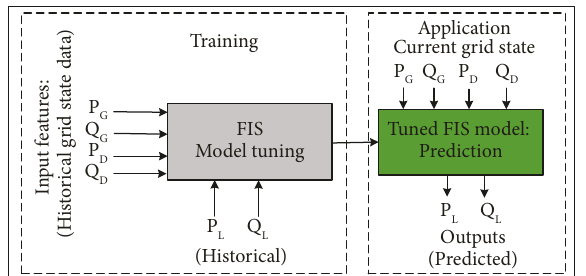
Figure 3: Fuzzy inference system for mapping inputs (generation & load) and outputs (line